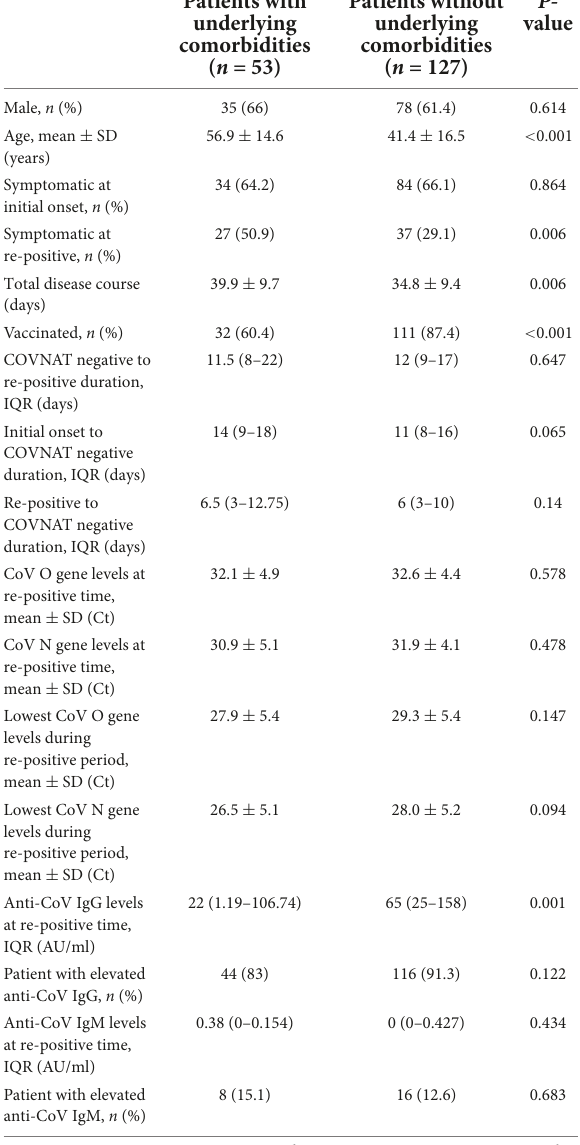
TABLE 2 Comparison of clinical characteristics and laboratory results between patients with or without underlying diseases at first positive and re-positive